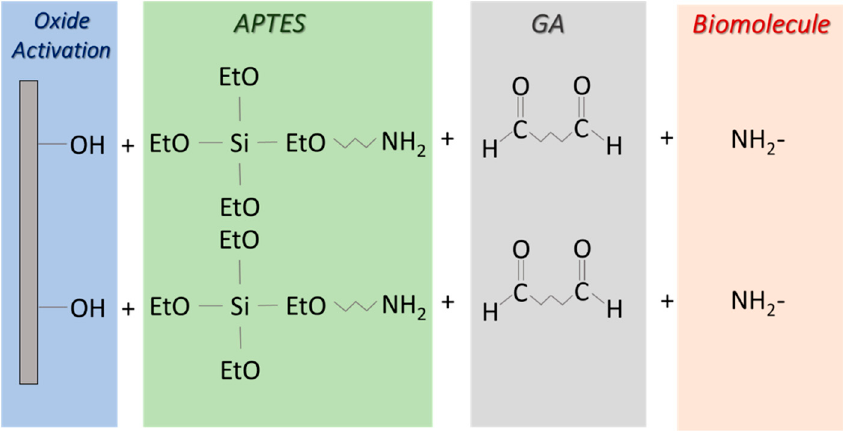
Figure A1. Schematic view of APTES protocol for biomolecule immobilization.